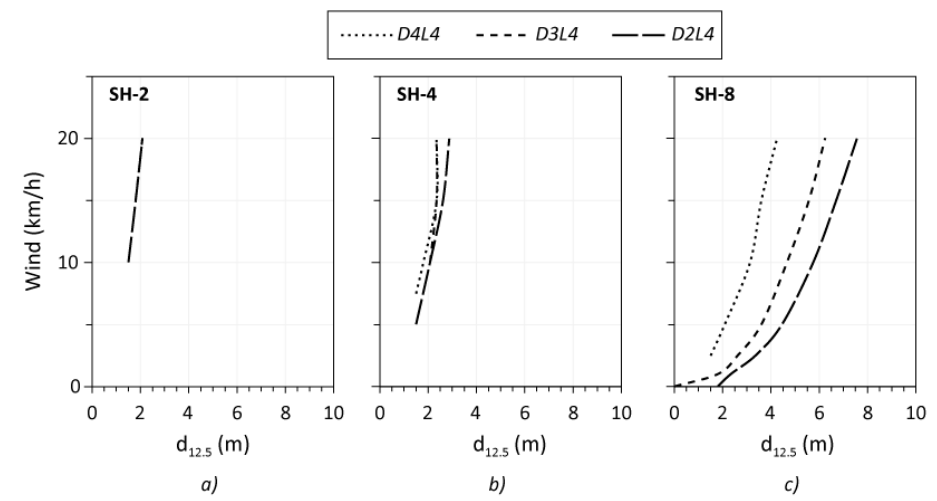
Figure 16. Safe separation distances as a function of wind speed at High MC (D4L4) for SH fuel models: ( a ) SH-2, ( b ) SH-4, ( c ) SH-8. models: ( a ) SH-2, ( b ) SH-4, ( c )